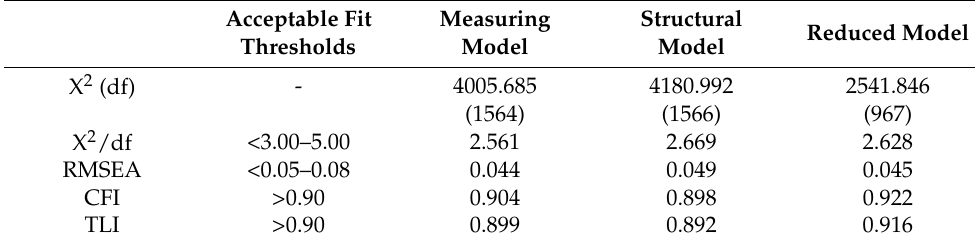
Table 3. Adjustments for measuring structural and reduced models ( n =